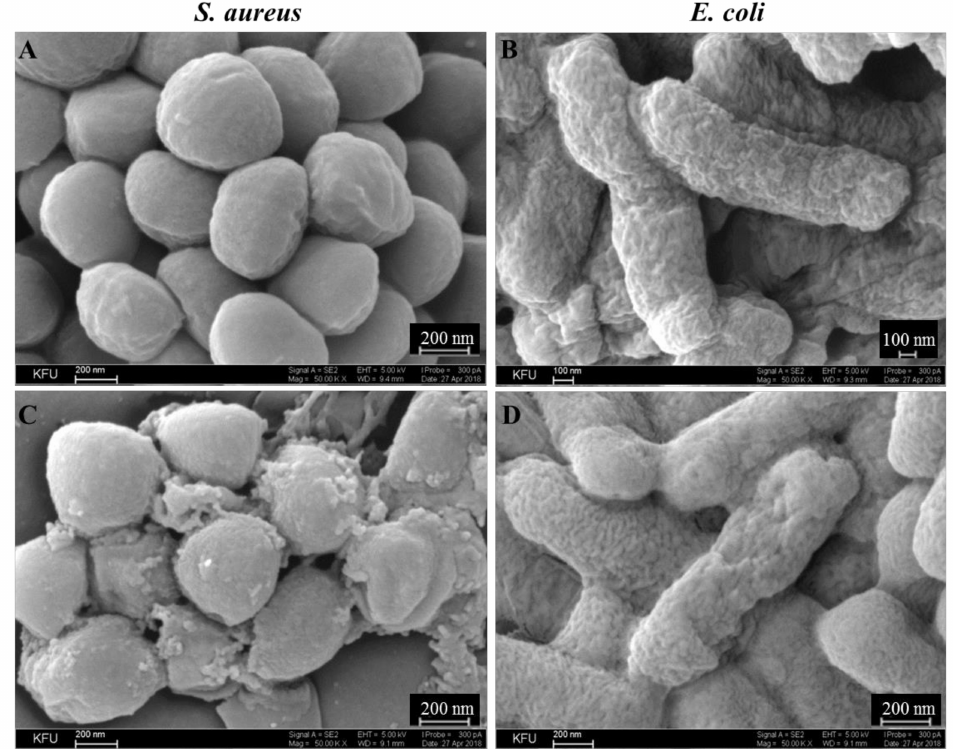
Figure 6. Scanning Electron Microscopy microphotographs of S. aureus ATCC209p ( A , C ) and E. coli CDC F-50 ( B , D ). Untreated cells ( A , B ) and bacteria treated by 0.2% solution of 5c 12 for 30 min ( C , D ). 50,000 ×